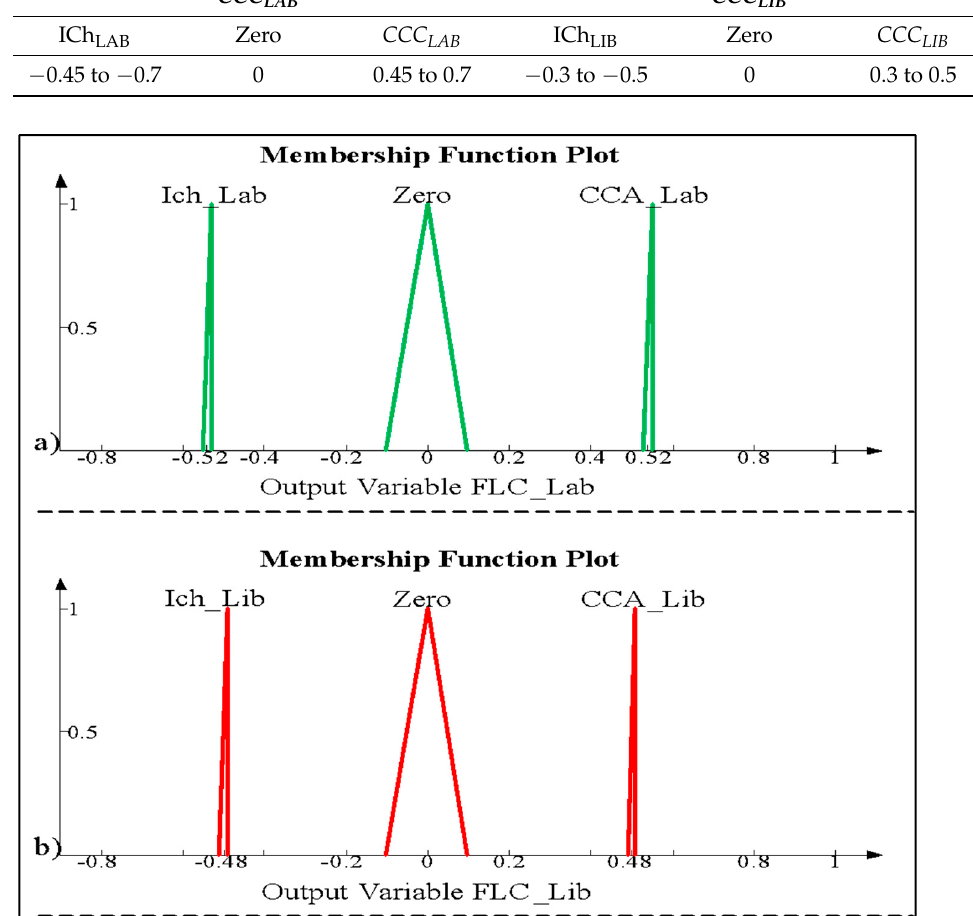
Figure 6. The membership function output variable of ( a ) CCC LAB and ( b ) CCC LIB .